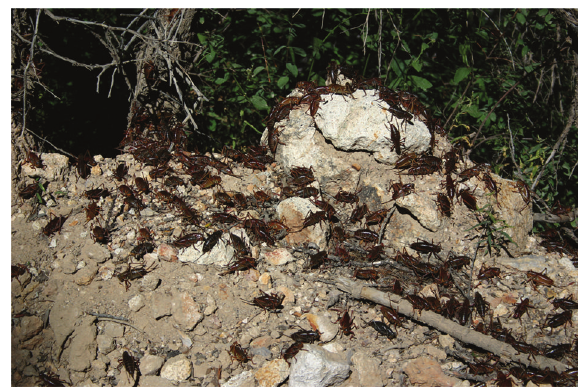
Figure 1: Migrating Mormon crickets basking near Jarbidge, Nevada in July